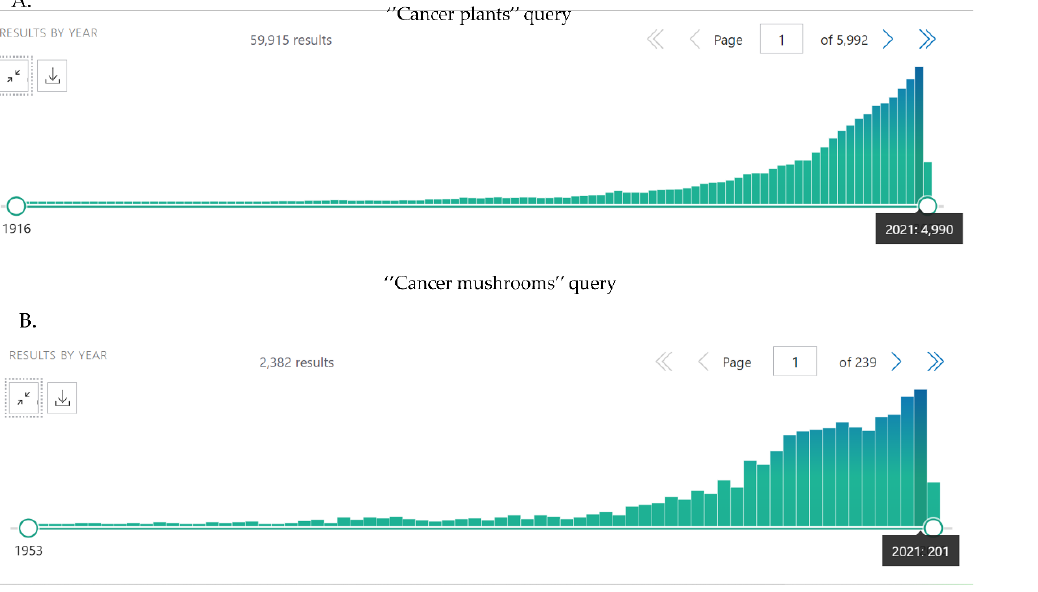
Figure 2. PubMed statistics by years on published articles on plants and fungi with antitumor properties (April 2022). Query on ( A ) “cancer plants” and ( B ) “cancer mushrooms”.